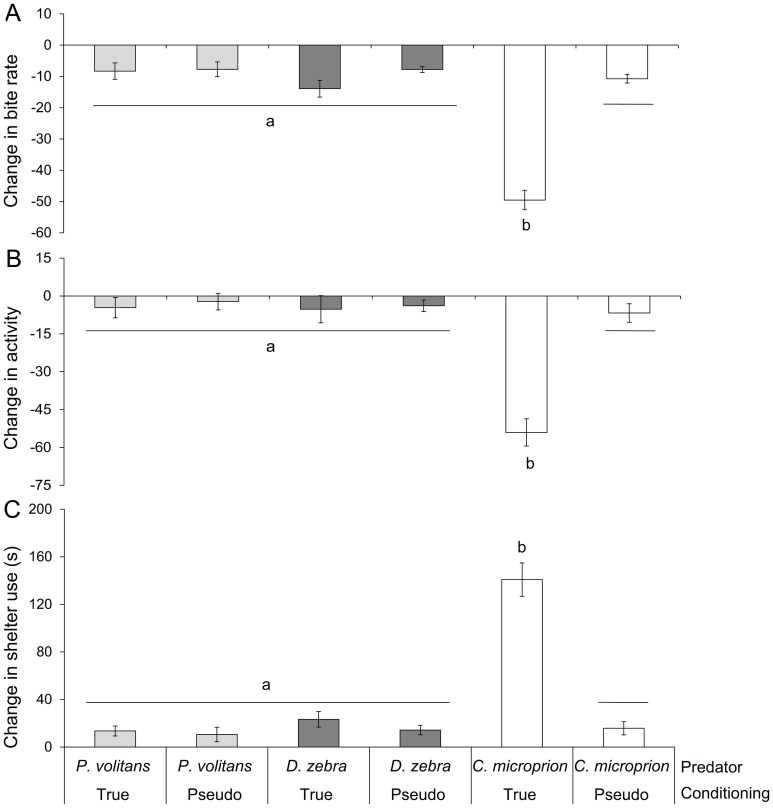
Behavioural responses of inexperienced and experienced juvenile Chromis viridis to the visual presentation of three different predators (N = 16–18).Antipredator responses were only seen in experienced prey exposed to Cephalopholis microprion. Prey reduced foraging (A), lowered activity rates (B) and increased shelter use (C). Letters indicate significant groupings.